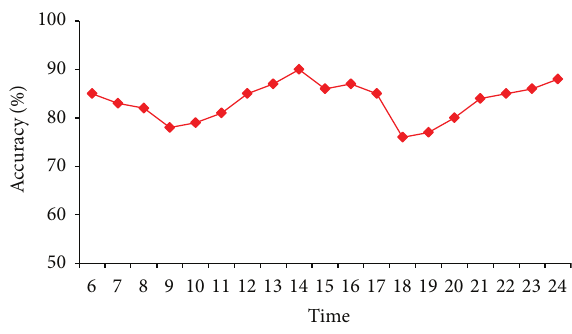
Figure 3: Accuracy of our prediction system (%).